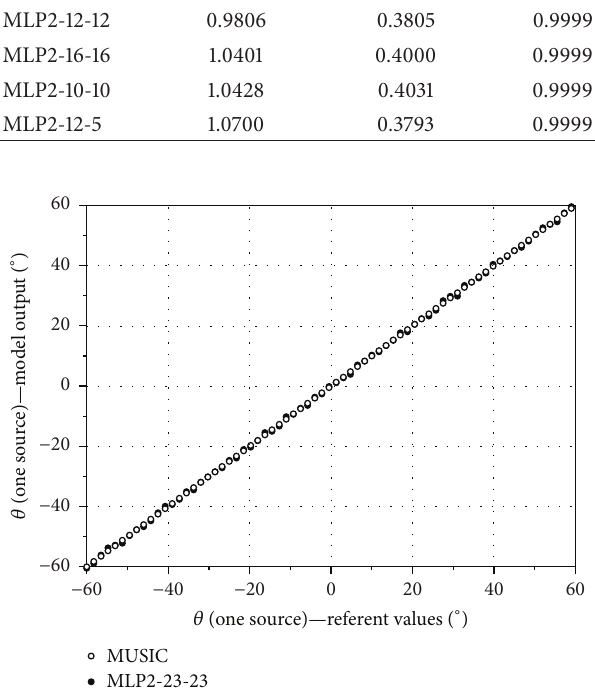
Figure 5: Scattering diagram of chosen MLP-DoA 1 network (MLP2-23-23) and the MUSIC model obtained by simulation on the test set (Case 𝑠 = 1